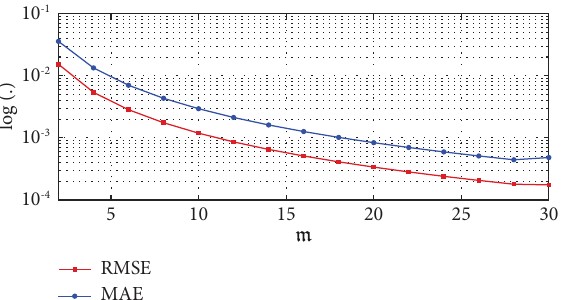
Figure 5: RMSE and MAE (in log scale) for diferent m for Example 3.